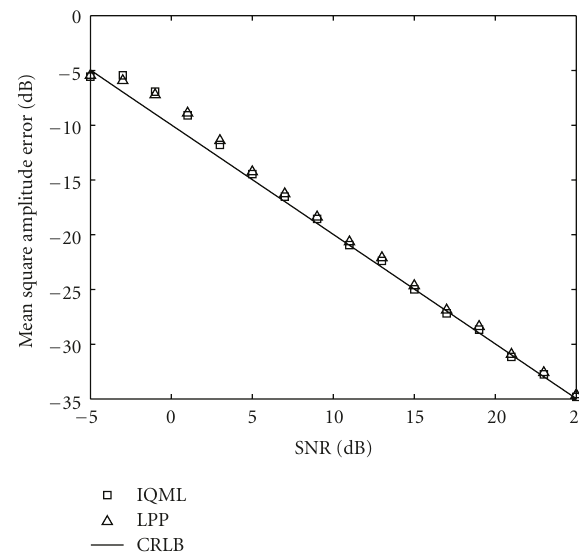
Figure 17: MSE for A 2 of multiple complex sinusoids.